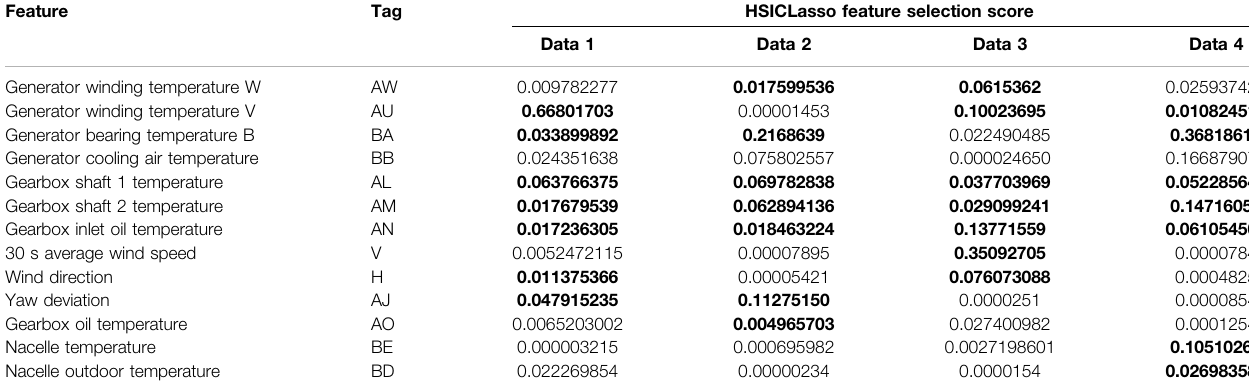
TABLE 3 | HSICLasso feature selection results.